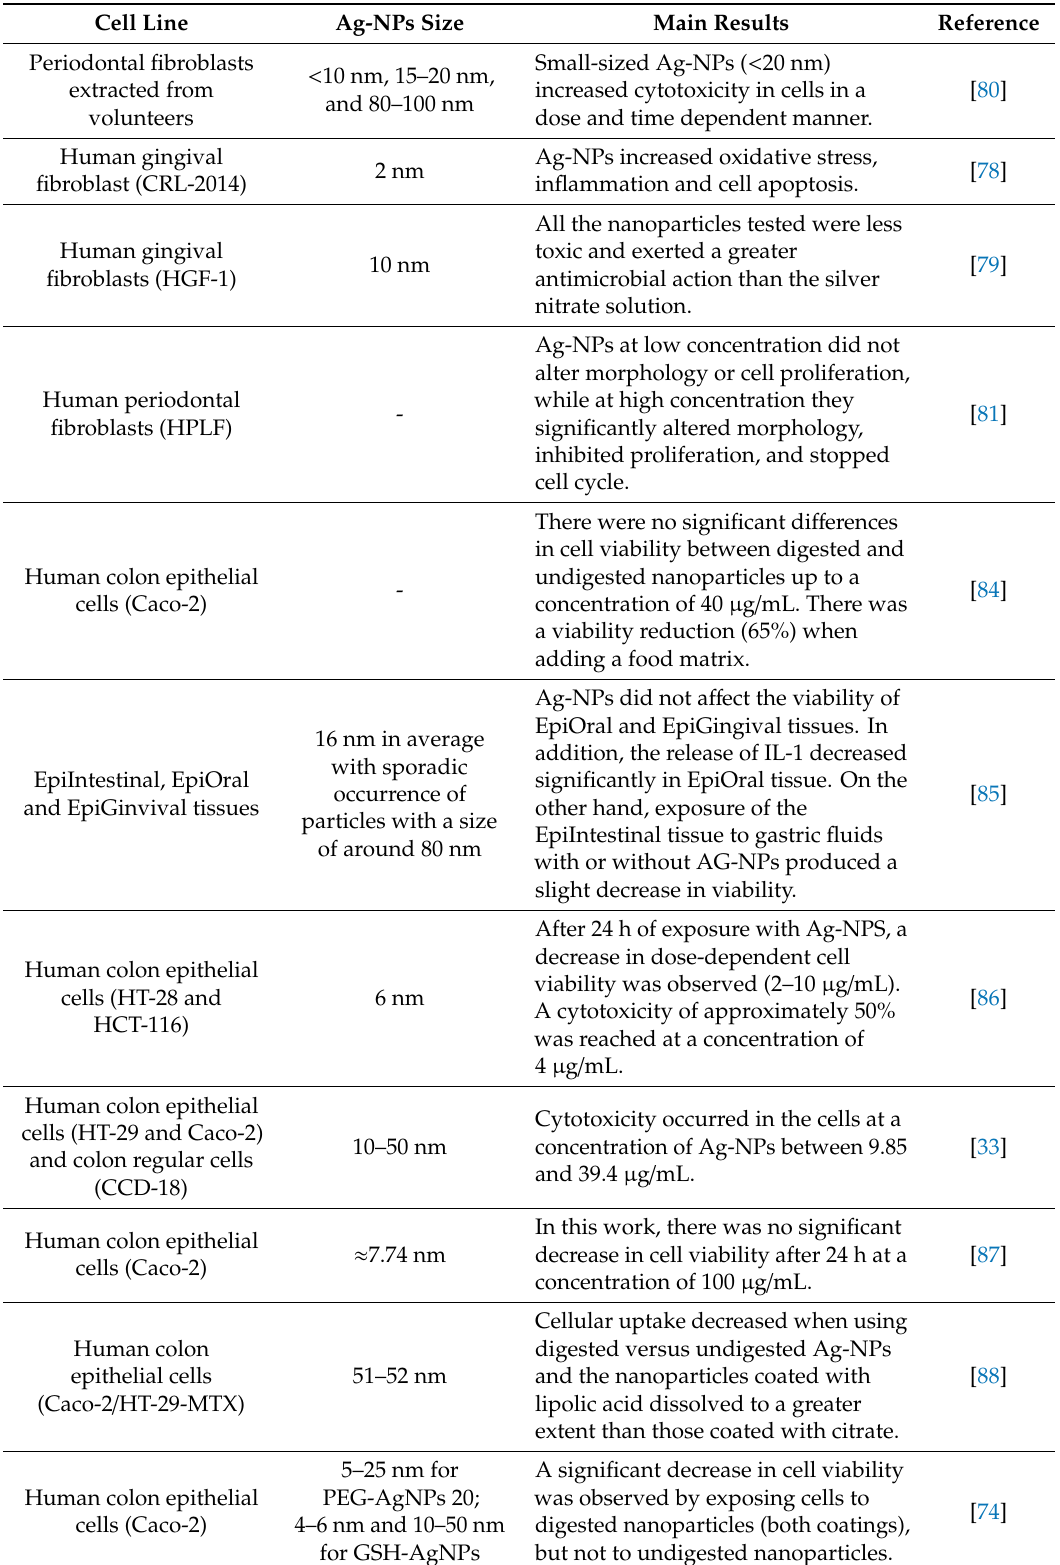
Table 2. Studies regarding silver nanoparticles cytotoxicity e ff ects in several cell